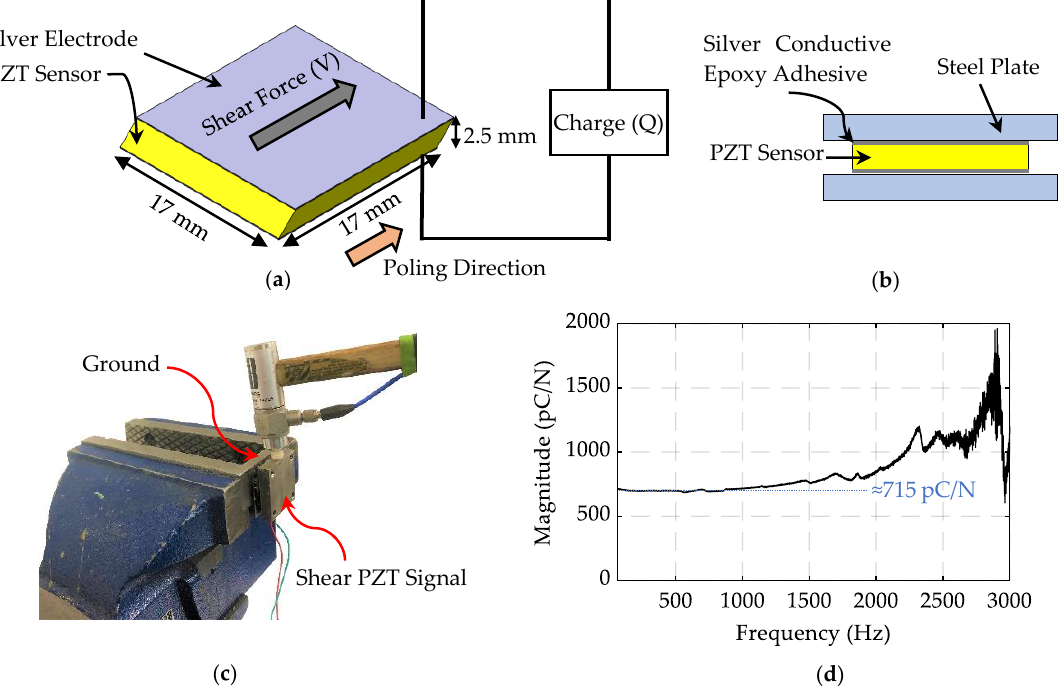
Figure 6. ( a ) Direction of applied shear force with respect to the poling direction to measure d 15 . ( b ) Schematic of the developed setup to measure d 15 . ( c ) Modal hammer test conducted on the clamped setup. ( d ) Frequency response function (FRF) result used to estimate the d 15 value of the shear elements